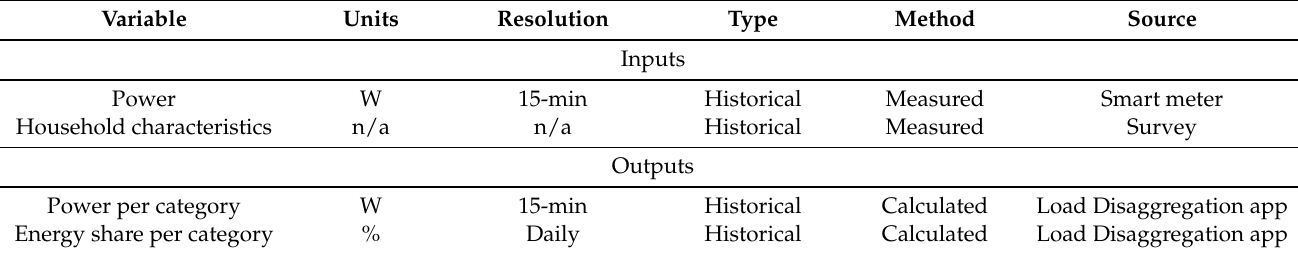
Table 12. Detailed list of inputs and outputs for residential Load Disaggregation application.